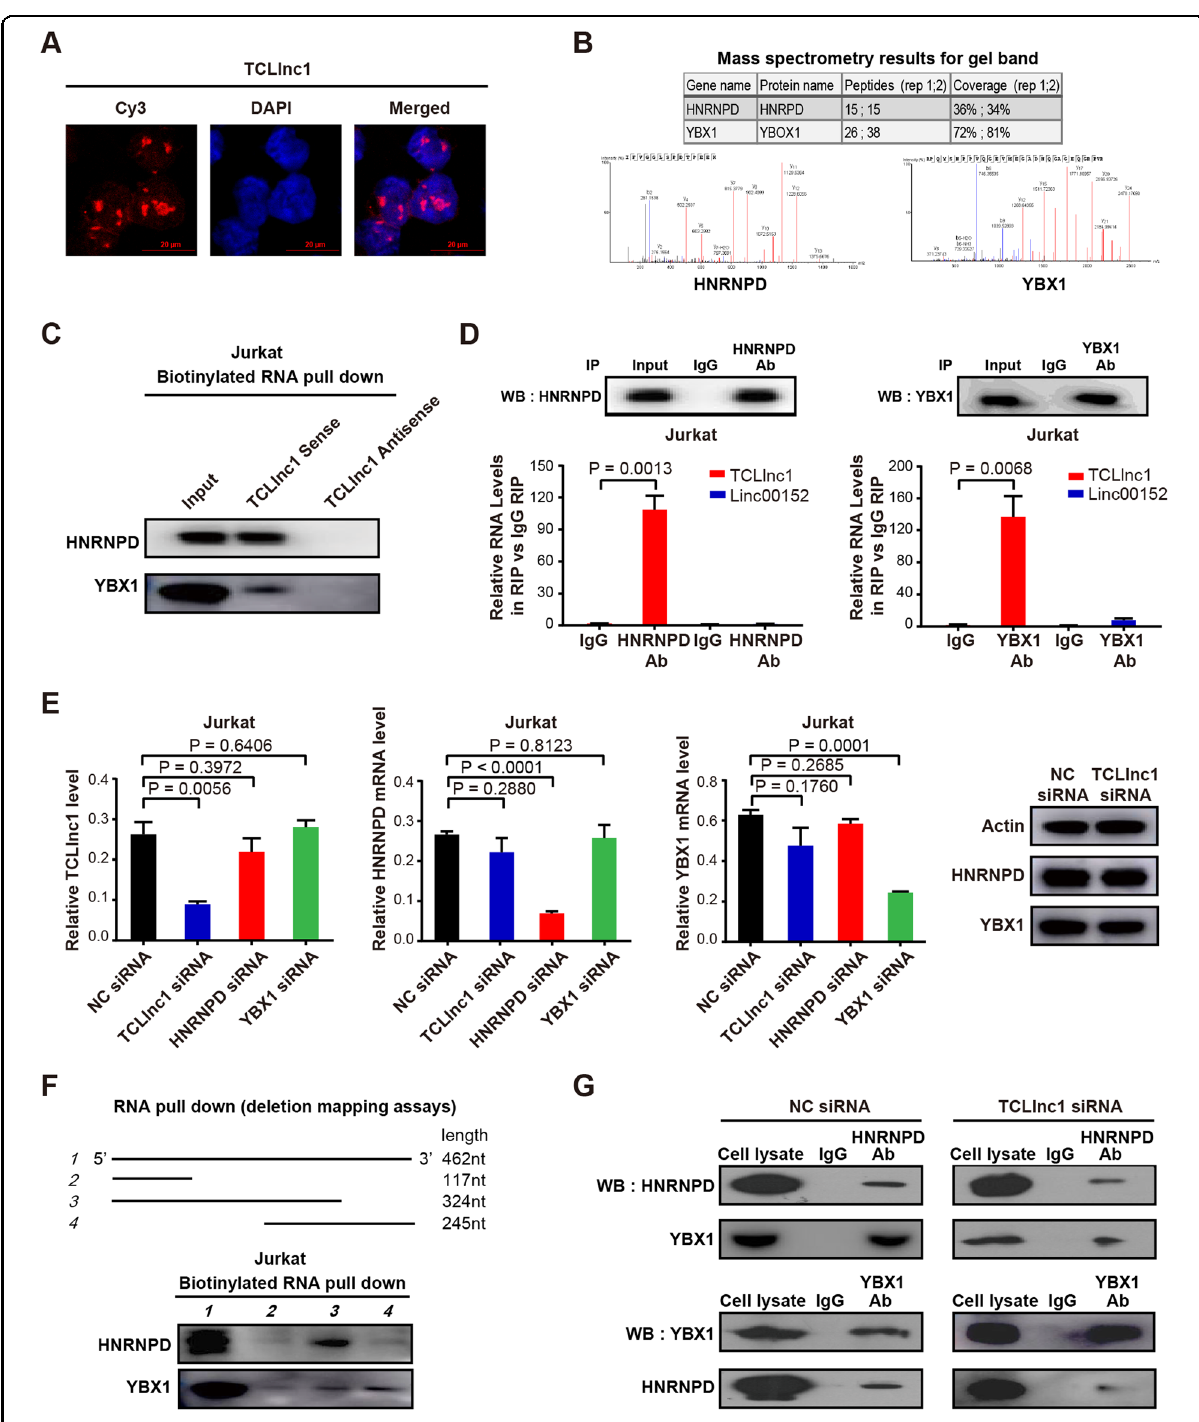
Fig. 6 TCLlnc1 physically interacted with heterogeneous nuclear ribonucleoprotein D (HNRNPD) and Y-box binding protein-1 (YBX1). A Nuclear location of TCLlnc1 in Jurkat cells (red). Nuclei were stained by 4 ′ , 6-diamidino-2-phenylindole (DAPI, blue). B TCLlnc1-binding proteins detected by mass spectrometry. C Western blot validation of proteins pulled down with TCLlnc1. D Interaction of TCLlnc1 with HNRNPD and YBX1 detected by RNA immunoprecipitation (RIP) assay. The fold enrichment of TCLlnc1 in RIP is relative to its matching IgG control RIP. LncRNA linc00152 was referred as a negative control. E Expression of TCLlnc1, HNRNPD, and YBX1 after indicated RNA knockdown detected by qRT-PCR and western blot. F Western blot analysis of HNRNPD and YBX1 pulled down by full-length or truncated TCLlnc1. G Interaction of HNRNPD and YBX1 after TCLlnc1 knockdown detected by co-immunoprecipitation